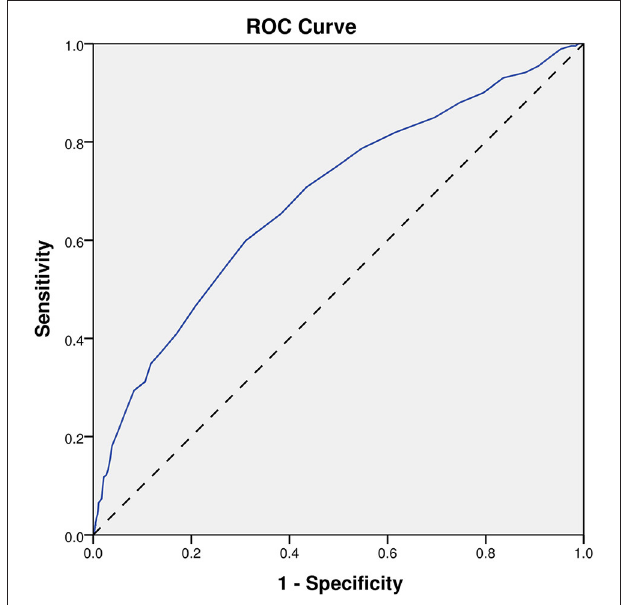
FIGURE 3 | ROC curve of INR. ROC, receiver-operating characteristic.